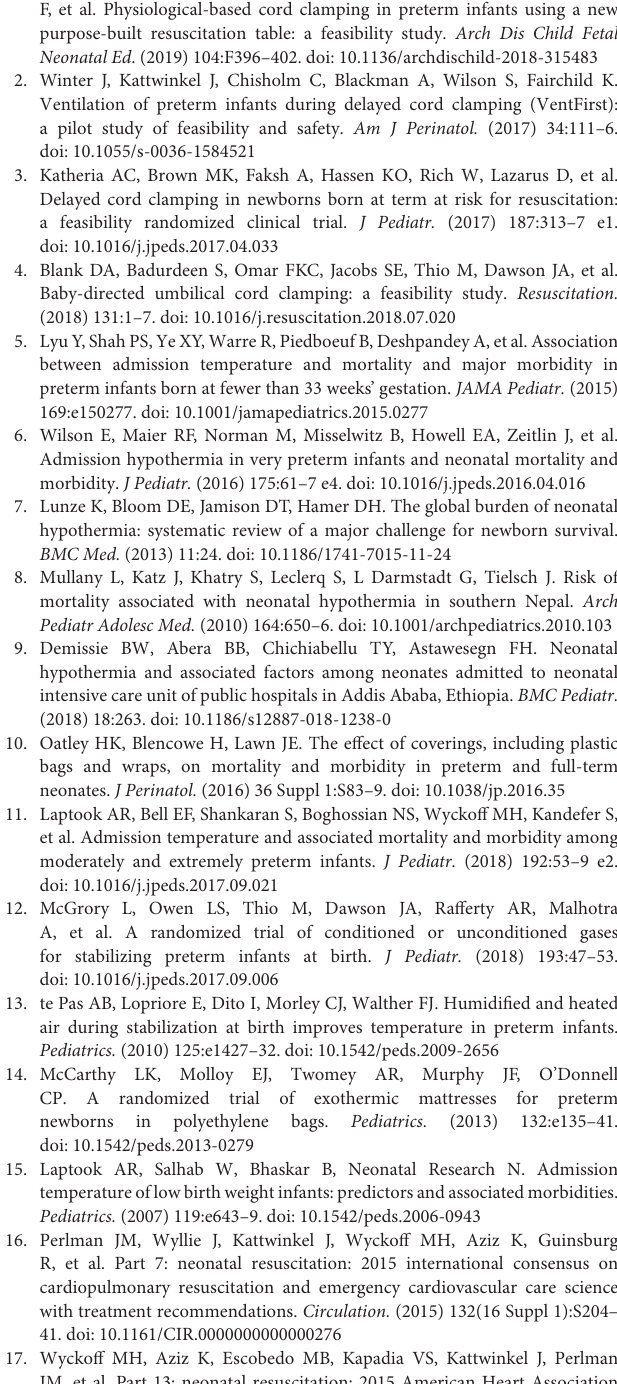
Games-Howell post-hoc analysis. ICC, immediate cord clamping; PBCC, physiological based cord clamping; m, minutes, ∗ denotes significant difference ( p < 0.05) in temperature between